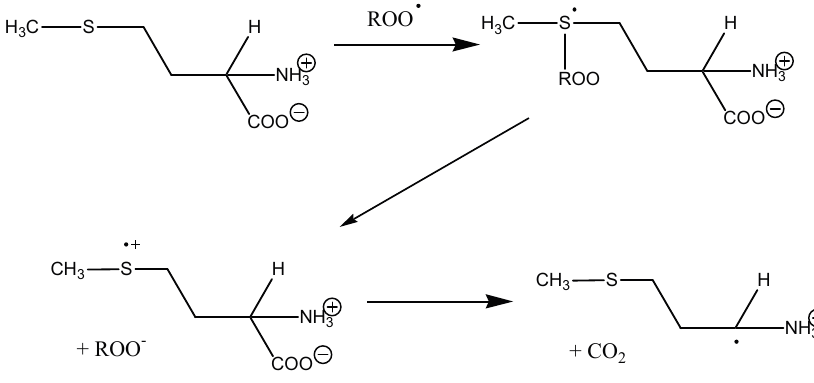
Figure 11. The mechanism of interaction of methionine with peroxyl